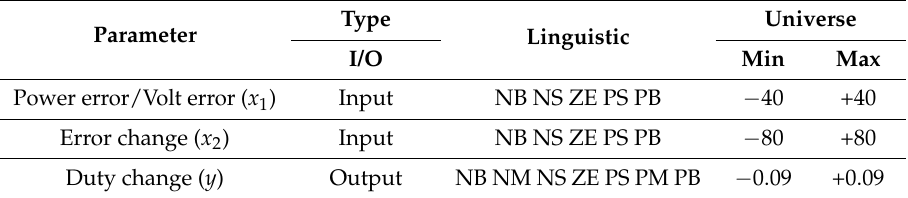
Table 1. The input and output variables and initial universe.